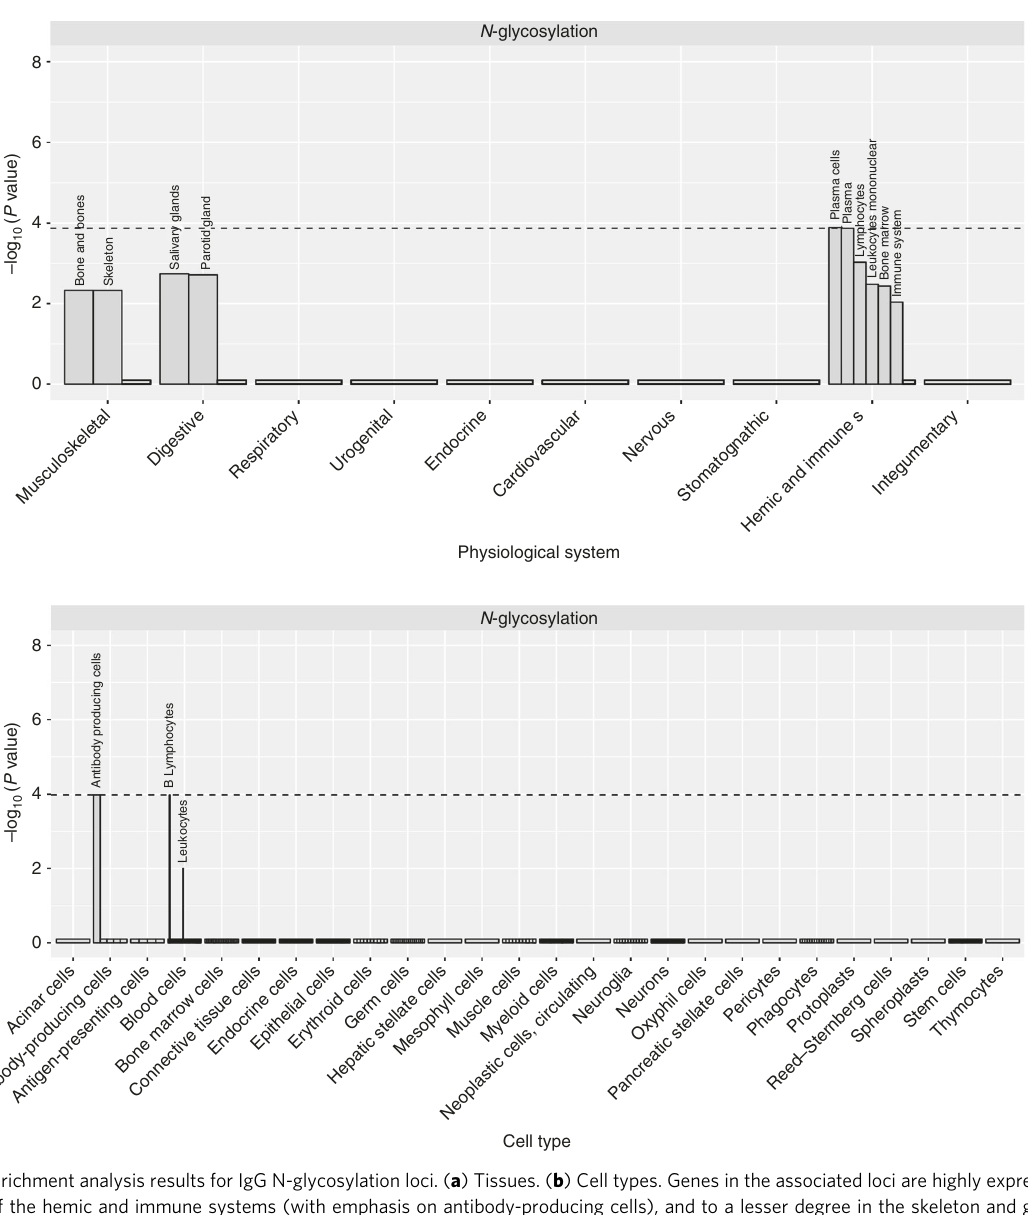
sets, using either genome-wide signi fi cant SNPs or SNPs with MANOVA P < 1×10 − 5 ) were run. Results are reported in Sup- plementary Data 2. The gene sets demonstrating most signi fi cant enrichment included regulation of protein kinase activity and Endoplasmic Reticulum-nucleus signaling pathway. The top enriched tissues/cell types included B-lymphocytes, plasma cells, antibody-producing cells, plasma (see Fig. 3 and Supplemetary Fig. 11 – 12 for trait group-speci fi c results).